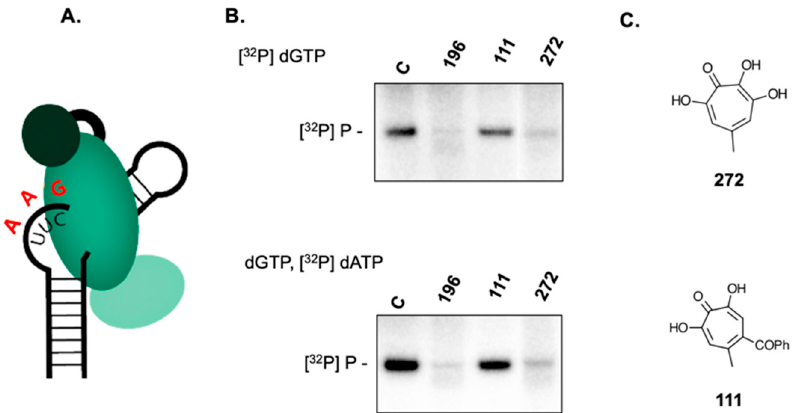
Figure 5. 3,7-dHTs inhibit initiation of ε -dependent initiation of HBV minus-strand DNA synthesis and subsequent elongation. ( A ) Cartoon of the priming event. The trinucleotide sequence -C-U-U-(black) represents template nucleotides + 1, + 2 and + 3, respectively. Inclusion of dGTP alone monitors initiation of DNA synthesis, while a mixture of dGTP and dATP (red) evaluates subsequent elongation steps. ( B ) dGTP (upper) and dGTP / dATP-primed reactions (lower) in the presence of 3,7-dHTs 196 and 272 and a control α -HT 111 . ( C ) structures of 3,7-dHT 272 and α -HT 111 . All analogs were tested at a final concentration of 100 µ